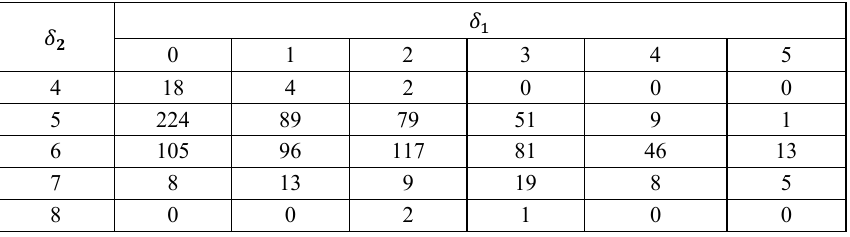
Table 3. Number of corresponding experimental samples when